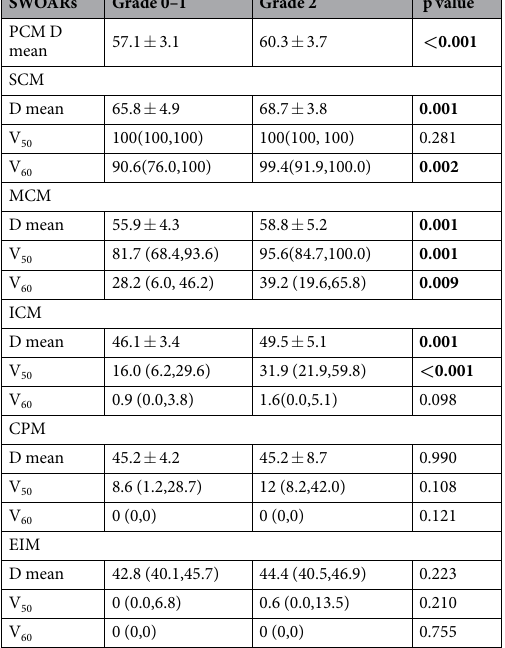
Table 3. Relationship between the dosimetric variables of the SWOARs and the degree of late dysphagia. D, dose; V 50,60, partial volume receiving specified dose of 50 Gy; 60 Gy; SCM, superior constrictor muscle; MCM, middle constrictor muscle; ICM, inferior constrictor muscle; CPM, cricopharyngeus muscle; EIM, esophageal inlet muscle.